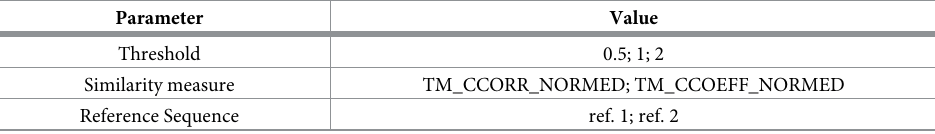
Table 1. Tested parameter